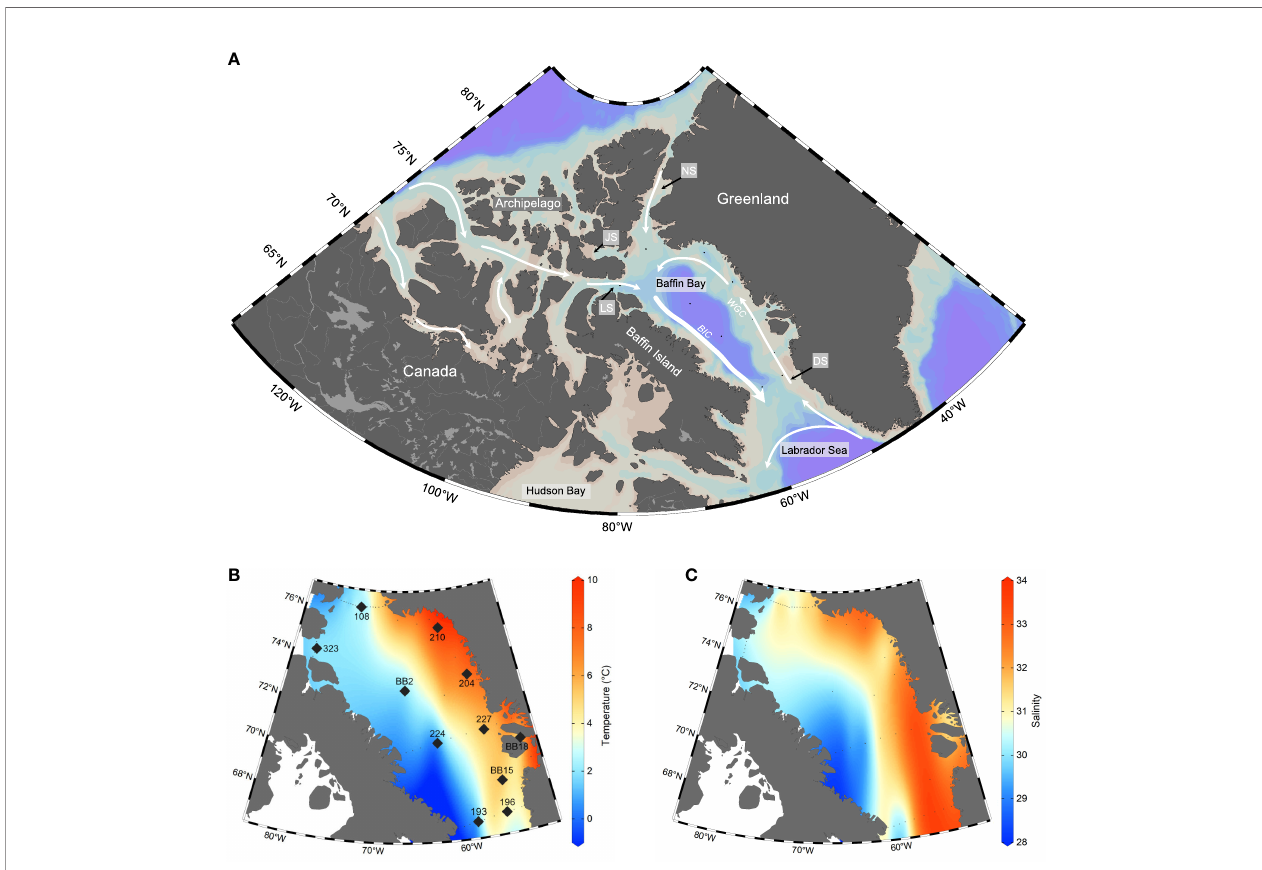
FIGURE 1 | Area and station maps with temperature and salinity in Baf fi n Bay. (A) broader area map indicates major currents (white arrows) land masses and Baf fi n Bay gateways (grey boxes). Gateways include Davis Strait (DS; 640m), Nares Strait (NS; 250m), Jones Sound (JS; 120m), and Lancaster Sound (LS; 300-800m). (B) Data from all stations visited in the 2019 research cruise were used to create the interpolated surface distributions of sea surface temperature (°C). Stations sampled for DIC are indicated by large black diamonds and labeled. (C) Data from all stations visited in the 2019 research cruise were used to create the interpolated surface distributions of salinity from 2-3 metres depth are reported in Practical Salinity Units (PSU). Plots b and c are Ocean Data View interpolations resulting from all CTD casts on the cruise (small black dots; n=52 stations) and are used to indicate the presence of the Baf fi n Island Current (BIC) and Western Greenland Currents (WGC) during the time of